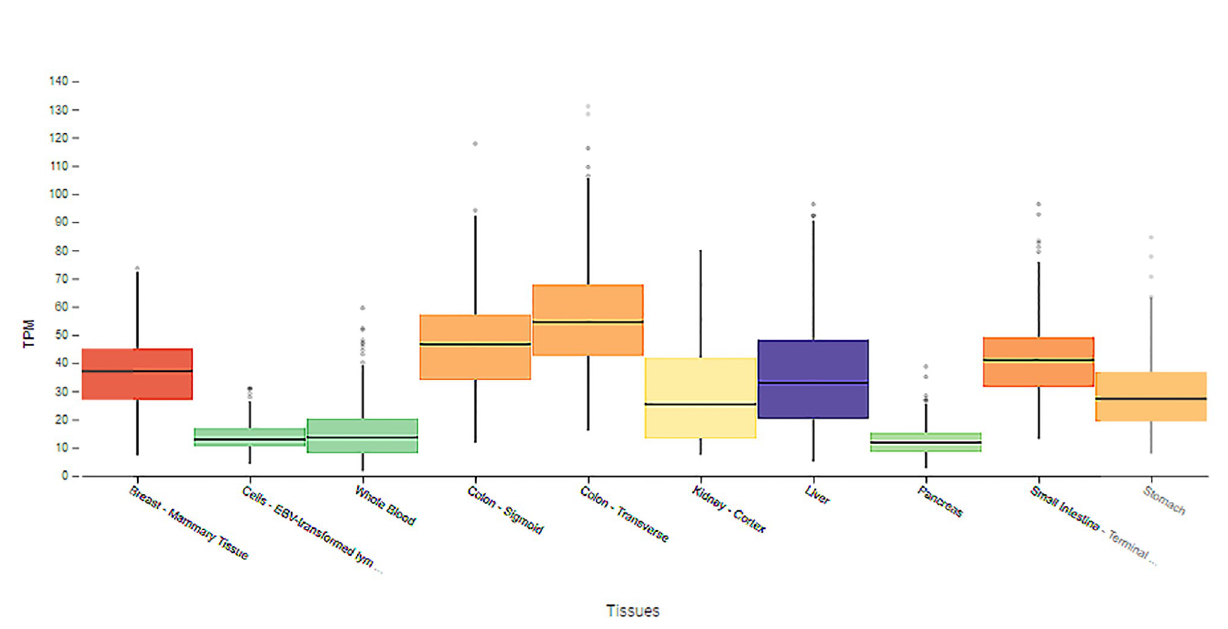
Fig 6. Transcripts per million (TPM) of CPT1A separated by tissue types in which CPT1A is present.